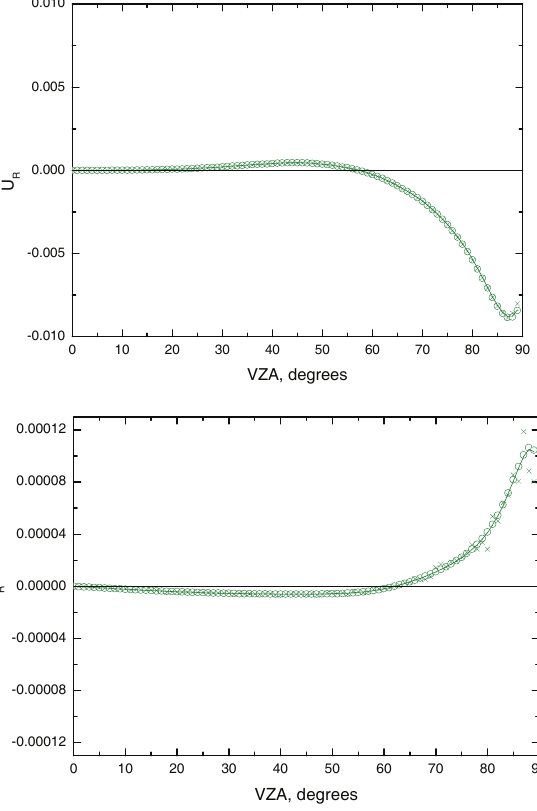
Fig. 4b. The same as in Fig. 4a except for the third and forth Stokes vector elements at ϕ = 90 ◦